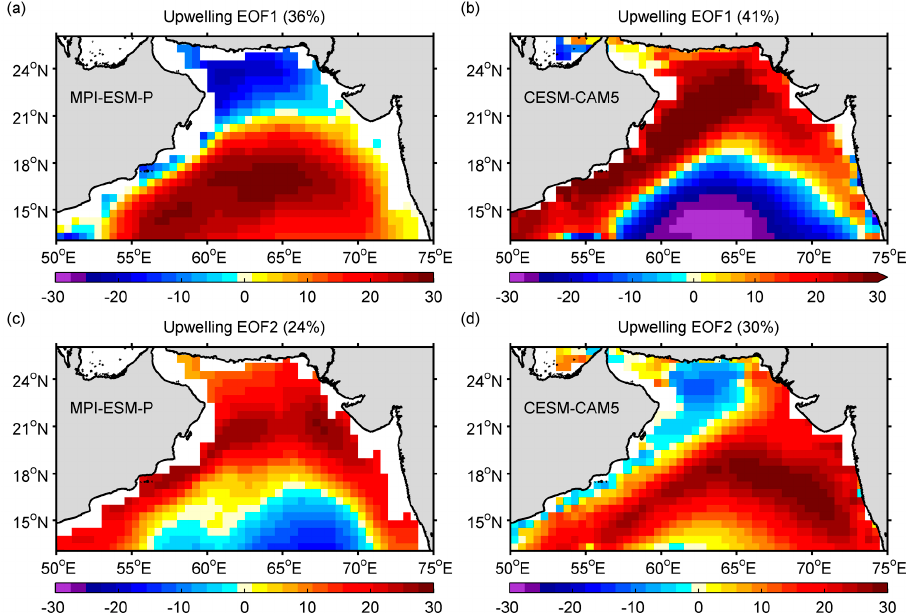
Figure 3. First EOF mode of JJA Arabian Sea upwelling velocity modeled by ( a ) MPI-ESM-P and ( b ) CESM-CAM5 and second EOF mode from ( c ) MPI-ESM-P and ( d ) CESM-CAM5 with their explained variance in brackets.